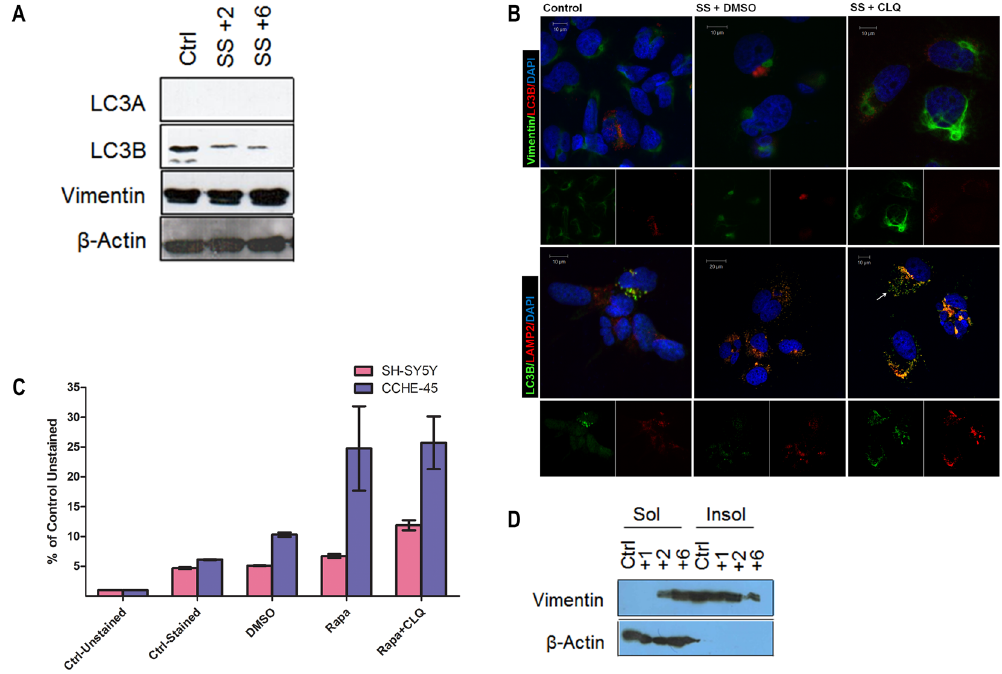
Figure 2. Increased autophagy flux in CCHE-45 cells is not blocked by lysosome inhibitor chloroquine. ( A ) Western blot analysis of CCHE-45 cells cultured under normal condition or serum starved for 2 or 6 hours in HBSS. β -actin was used as a loading control. ( B ) Immunofluorescence staining of CCHE45 cells. Cells were cultured under normal condition or serum starved in HBSS for 5 hours or serum starved and treated with 50 µ M chloroquine. CCHE-45 cells were immunostained with rabbit anti-vimentin (green) and mouse anti-LC3B (red), or rabbit anti-LC3B (green) and mouse anti-LAMP2 (red) and visualized using Alexa Fluor 488 goat anti- rabbit antibody or Alexa Fluor 555 goat anti-mouse. White arrow heads show LC3B positive autophagosomes. ( C ) Flow cytometry-based profiling of CYTO-ID Autophagy detection for CCHE-45 and SH-SY5Y cells. Mean fluorescent intensity comparison between CCHE-45 and SH-SY5Y is representative of three independent experiments. Statistical analysis was performed using paired student’s t test. The level of significance was set at p-value of 0.05. Error bars represent average ± SEM. ( D ) Western blot analysis of soluble and insoluble protein fractions collected from CCHE-45 cells cultured under normal conditions or treated with HBSS for 1, 2 or 6 hours. Ctrl = control, SS = serum starved, Rapa = rapamycin, CLQ = chloroquine, Sol = soluble protein fraction, Insol = insoluble protein